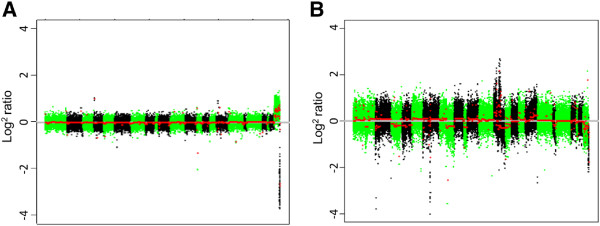
Normal and malignant copy number profiles. (A) CN profile for normal female versus male reference. (B) CN profile for a highly aneuploid cancer genome (versus male reference) derived from the Infinium arrays. Individual chromosomes are shown in green/black and segmented CN is shown in red.